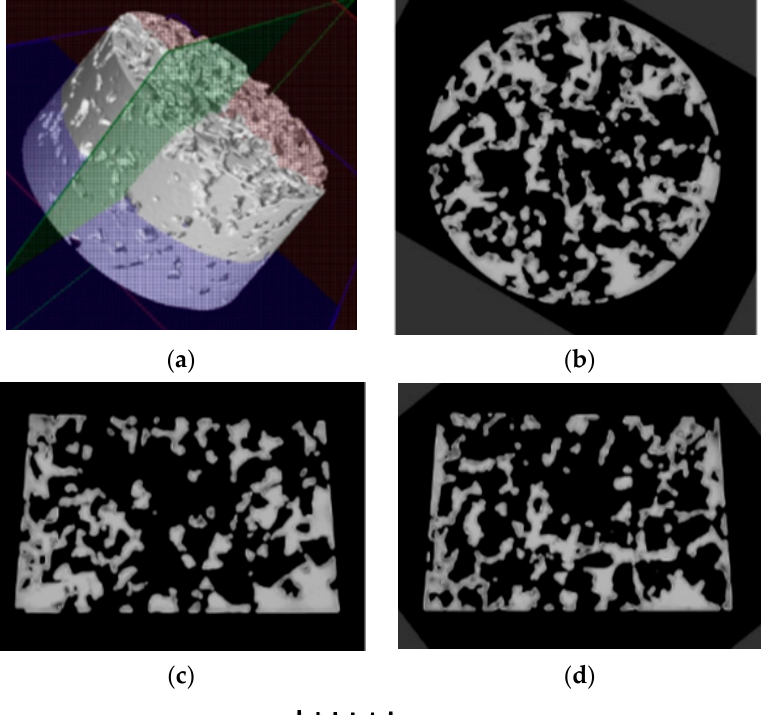
Figure 22. Demonstration of porosity in selected planes of aluminium porous material, AlSi12 sample SAM4, evaluated on a METROTOM 1500 CT ZEISS industrial computed tomograph: diagram of planes of section through porous sample ( a ); cut plane—purple colour ( b ); cut plane—red colour ( c ); cut plane—green colour ( d ).